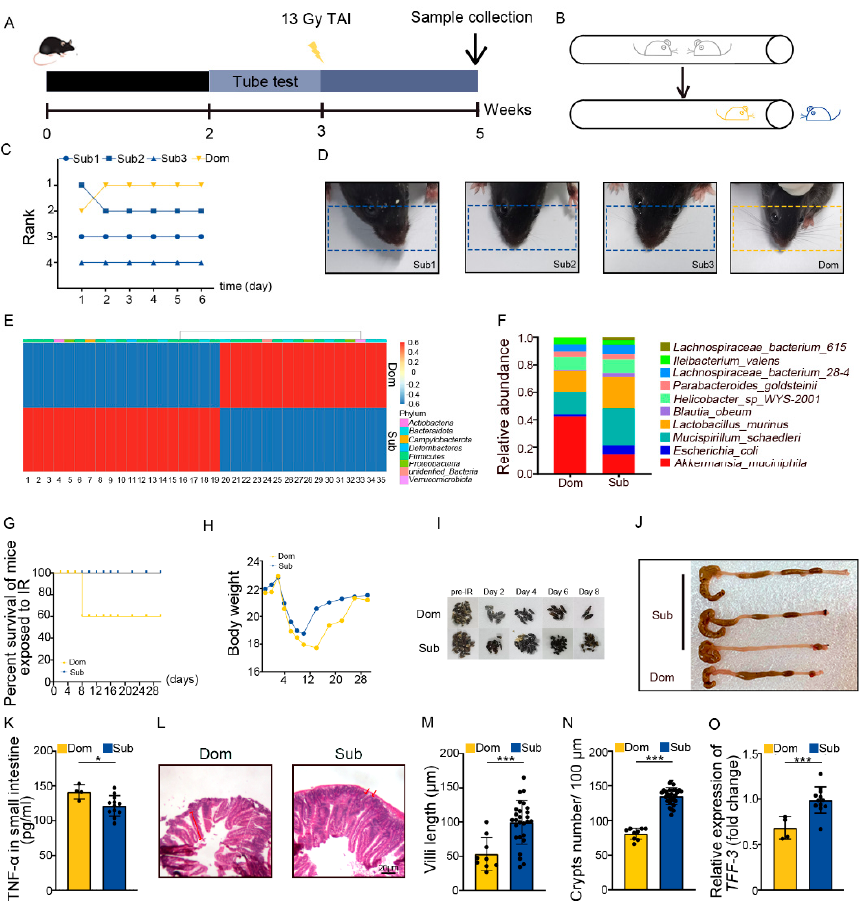
Figure 1. Social hierarchy determines the degree of intestinal radiation injury. ( A ) Experimental protocol. ( B ) Schematic of the tube test. ( C ) The ranking positions of one cage of mice tested daily over 6 days. ( D ) Photographs of barber and receptor mice. ( E ) Differences in gut microbiota at the genus level between Dom and Sub mice were assessed by 16S rRNA. Details of the bacteria are listed in Supplementary Table S2. ( F ) The relative abundance of the top 10 different strains of bacteria at the genus level in mice of the two groups. ( G ) Survival rate of Dom and Sub mice after irradiation. ( H ) Body weight of mice after exposure to irradiation. ( I ) Photographs of formed fecal pellet from experimental mice before and after irradiation. ( J ) Photographs of dissected colons from mice in the two groups. ( K ) Protein levels of TNF −α in small intestines were measured by ELISA. ( L ) Morphology of the small intestine was shown by H&E staining. ( M ) Length of small intestinal villi in Dom and Sub mice. ( N ) The number of small intestinal crypts in Dom and Sub mice. ( O ) The mRNA expression levels of TFF − 3 in small intestine tissues from Dom and Sub mice were examined by qRT − PCR. Statistically significant differences are indicated: Student’s t test, n = 4 in Dom group, n = 12 in Sub group, * p < 0.05 and *** p < 0.001.